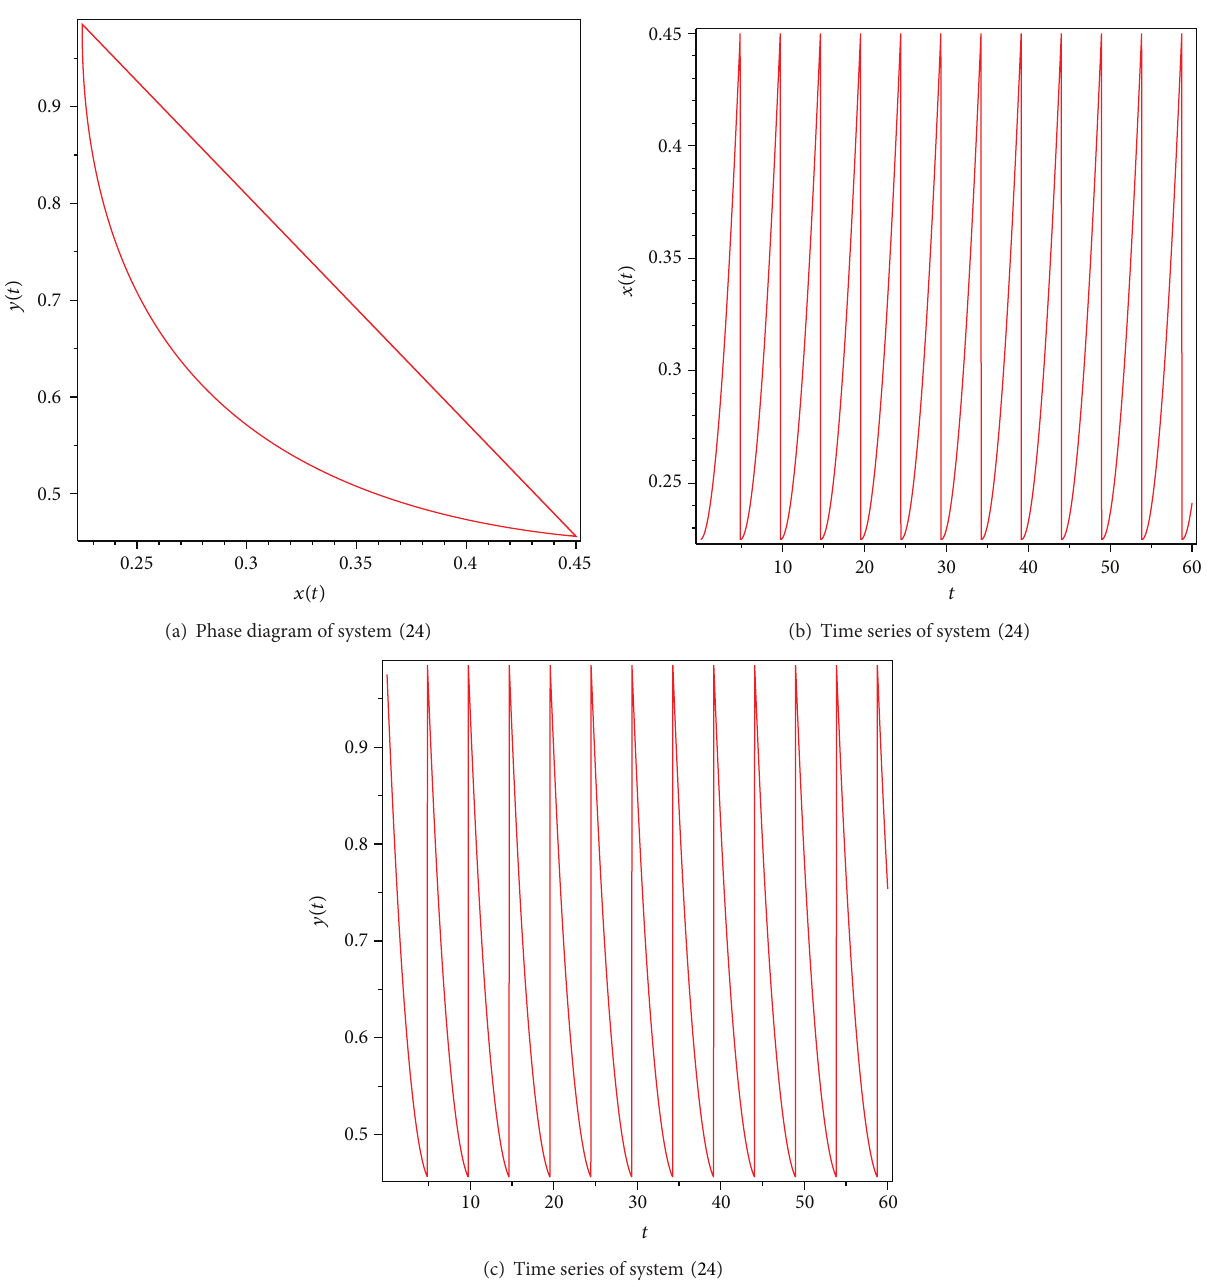
Figure 19: Illustration of basic behavior of system